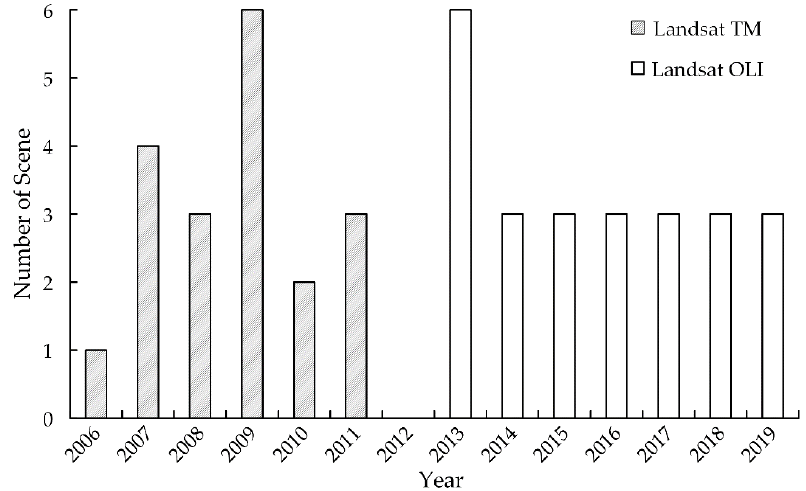
Figure 2. The number of Landsat Thematic Mapper (TM) and Operational Land Imager (OLI) images acquired in each year used in this study.